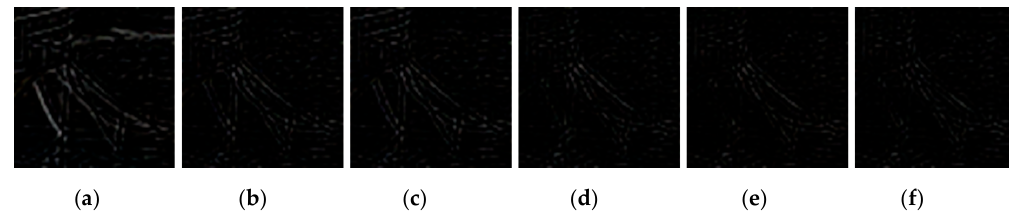
Figure 9. Deblurred results for test image with 17 × 17 Gaussian blur kernel of deviation 1.6. The first row shows the sharp image and deblurred images for the evaluated methods. The second row shows the enlarged views of the region marked with the green box in the original image and the deblurred images. ( a ) Original image [37]; ( b ) ECP; ( c ) EPLL; ( d ) NCSR; ( e ) SRN; ( f ) DPDNN; ( g ) proposed method.